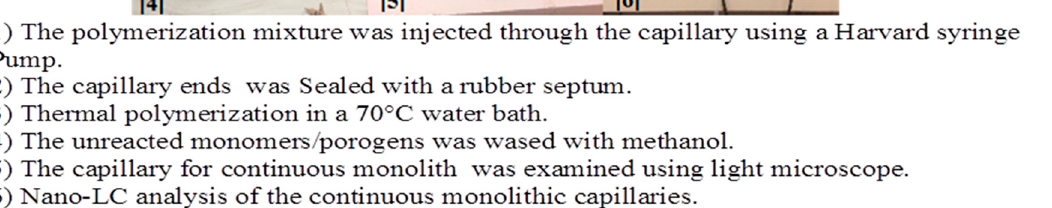
Figure 6. Steps showing the preparation of polymer monolithic capillary columns.